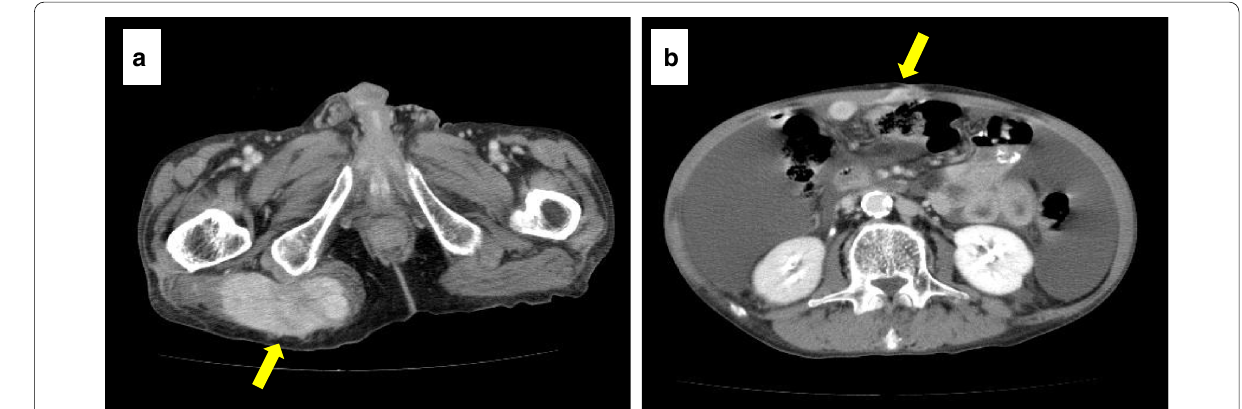
Fig. 4 Abdominal contrast-enhanced computed tomography images 8 months after gastrectomy. a Enlarged right gluteal muscle metastasis (arrows). b Disseminated nodule on the abdominal wall (arrows) and increased ascites can be observed